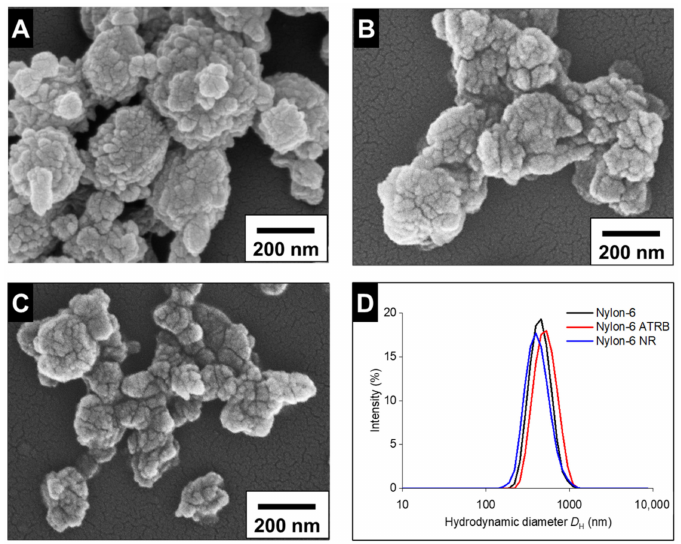
Figure 2. The SEM images for nylon-6 ( A ), nylon-6 ATRB ( B ), and nylon-6 NR ( C ) NPs along with their corresponding DLS profiles ( D ). The DLS profile is an average of 3